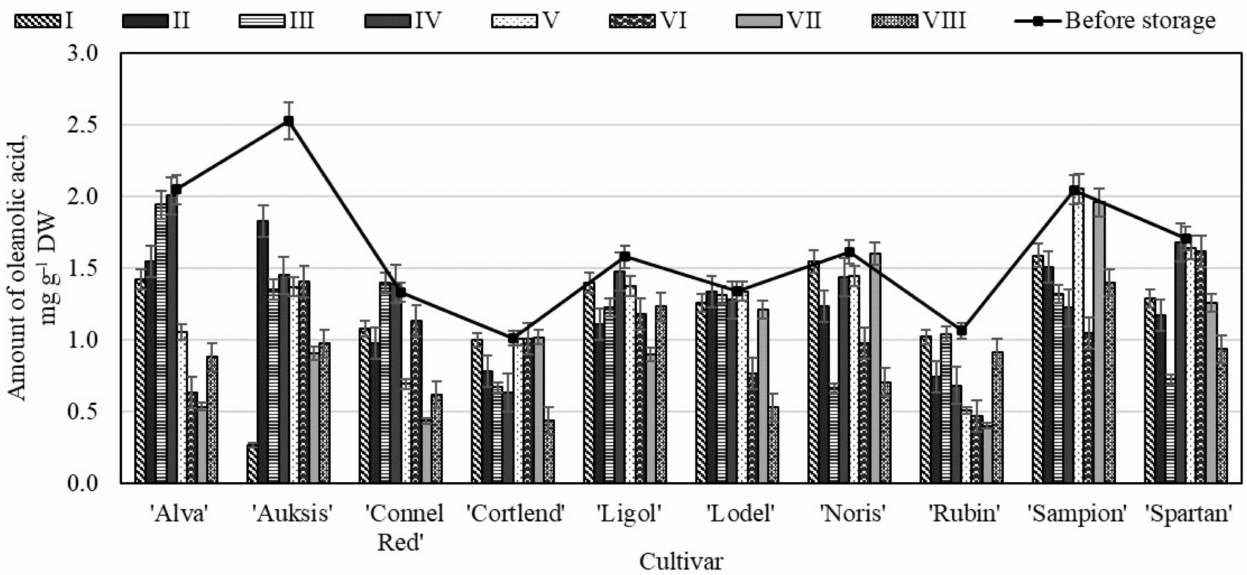
Figure 8. Changes in the amount of oleanolic acid in the apple peel samples before and after storage in CA. The study showed that before storage the highest amount of corosolic acid (1.31 ± 0.08 mg g − 1 ) was determined in the apple peel samples of the ‘Sampion’ cul- tivar, and the lowest content (0.63 ± 0.07 mg g − 1 )—in the samples of the ‘Auksis’ cultivar (Figure 9). Researchers have evaluated that that the amount of corosolic acid in the ap- ple peel samples grown in Lithuania, Poland and Estonia varied from 0.29 mg g − 1 to 0.49 mg g − 1 [47].